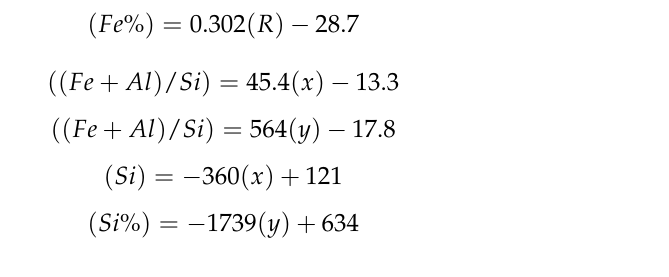
Table 2. Correlation coefficient of discolored seawater color (R, G, B, x , and y ) and its chemical composition (Fe, Al, Si, (Fe + Al)/Si, Fe%, Al%, and Si%). Chemical Composition R G